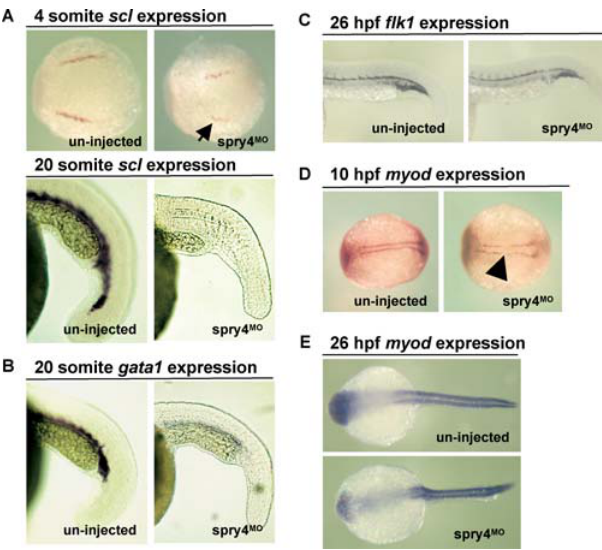
Figure 5. spry4 Is Required for Early Hematopoietic Development, but Not Mesodermal Commitment, in Developing Zebrafish Embryos (A) Expression of the early hematopoietic marker scl was reduced at the four-somite stage (arrow) and virtually absent at the 20-somite stage in spry4 MO embryos compared to uninjected controls. (B) The more mature hematopoietic marker gata1 was also reduced in spry4 MO compared to uninjected zebrafish embryos at 20 somites. (C and D) In contrast to hematopoietic genes, the mesodermal-specific flk1 (vasculature) transcripts were expressed at similar levels to uninjected controls at 26 hpf, and myod (muscle) had a slight defect (arrowhead) at 10 hpf, while expression was similar to controls at 26 hpf. All images are representative of greater than or equal to two experiments of n (cid:3) 8 embryos. DOI: 10.1371/journal.pbio.0030254.g005 PLoS Biology |